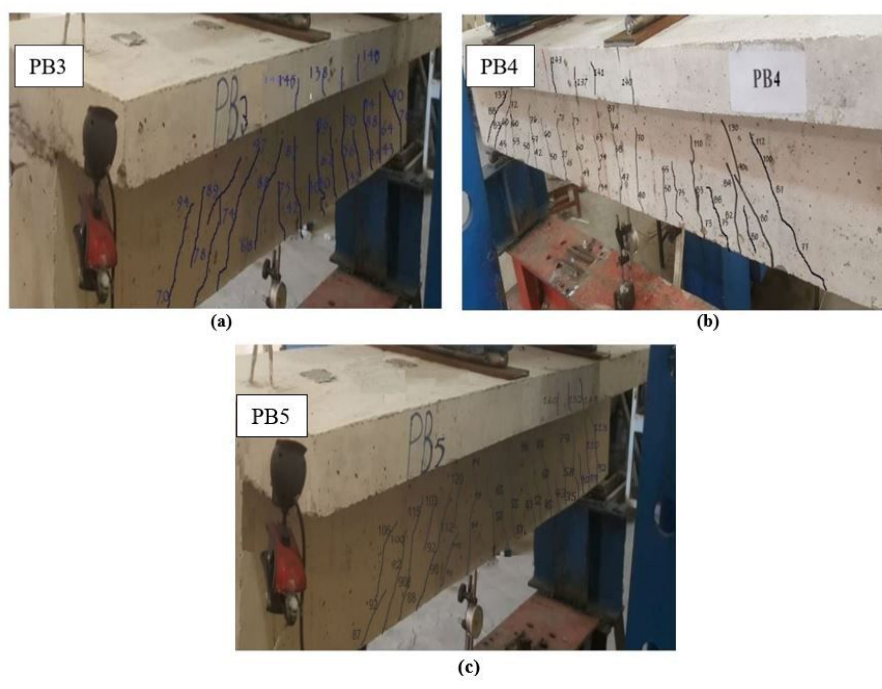
Figure 8: Cracking patterns of mechanical connecting beams: (a) PB3; (b) PB4; (c) PB5